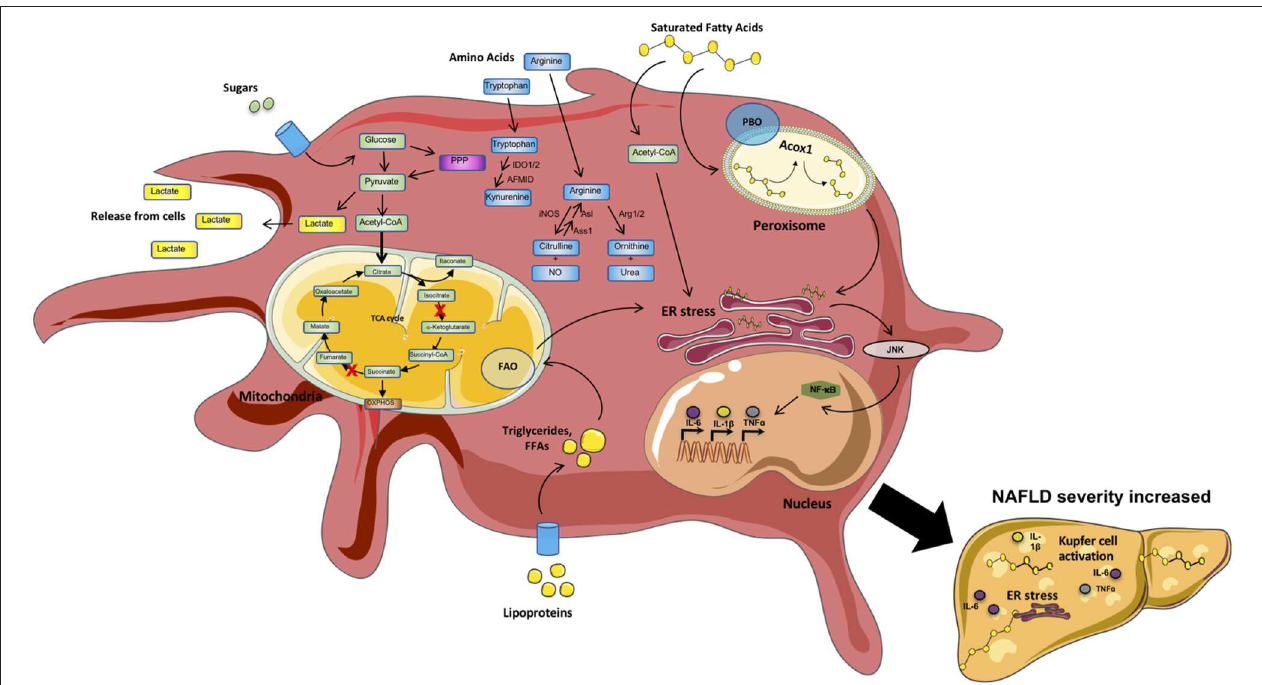
FIGURE 2 | Metabolic processes within inflammatory macrophages. Macrophages are highly metabolically active cells. Their metabolic identity is impacted by inflammatory mediators. In contrast, specific metabolic pathways (Fatty acid synthesis [FAS], Glycolysis, Amino acid [AA] metabolism) regulate the type of mediators produced by these cells. During a proinflammatory state, inflammatory mediators (e.g., sugars, lipoproteins, saturated fatty acids [SFAs], cytokines [IL6, TNF]) trigger “classical” activation of circulating and tissue resident macrophages (e.g., Kupfer cells and adipose tissue macrophages [ATMs]). Circulating sugars are taken up and processed via glycolysis/TCA cycle. In addition, several intermediate metabolites, as well as amino acids L-arginine, L-tryptophan and glutamine, can impact macrophage effector functions. Sensing/uptake of excessive lipoproteins and SFAs activates the mitochondrial fatty acid oxidation (FAO) and peroxisomal fatty acid beta-oxidation (PBO) pathways to breakdown long chain and very long chain fatty acids, respectively. Excessive activation of these pathways triggers ER stress and signaling via JNK and NF-kB, resulting in amplified production of proinflammatory mediators. “Classical” macrophage activation shifts the cells toward preferential utilization of glycolytic pathways with altered enzyme activity within the tricarboxylic acid cycle (TCA) cycle generating more lactate and fast energy production in the form of ATP to generate inflammatory mediators (e.g., IL-6, TNF, IL1). Metabolism of tryptophan (L-TRP) and arginine (L-ARG) by macrophages regulates key immunologic processes. Cumulatively, these inflammatory mechanisms fuel the overall systemic and tissue inflammation, hepatocyte death, and fibrosis in turn amplifying NAFLD pathogenesis.